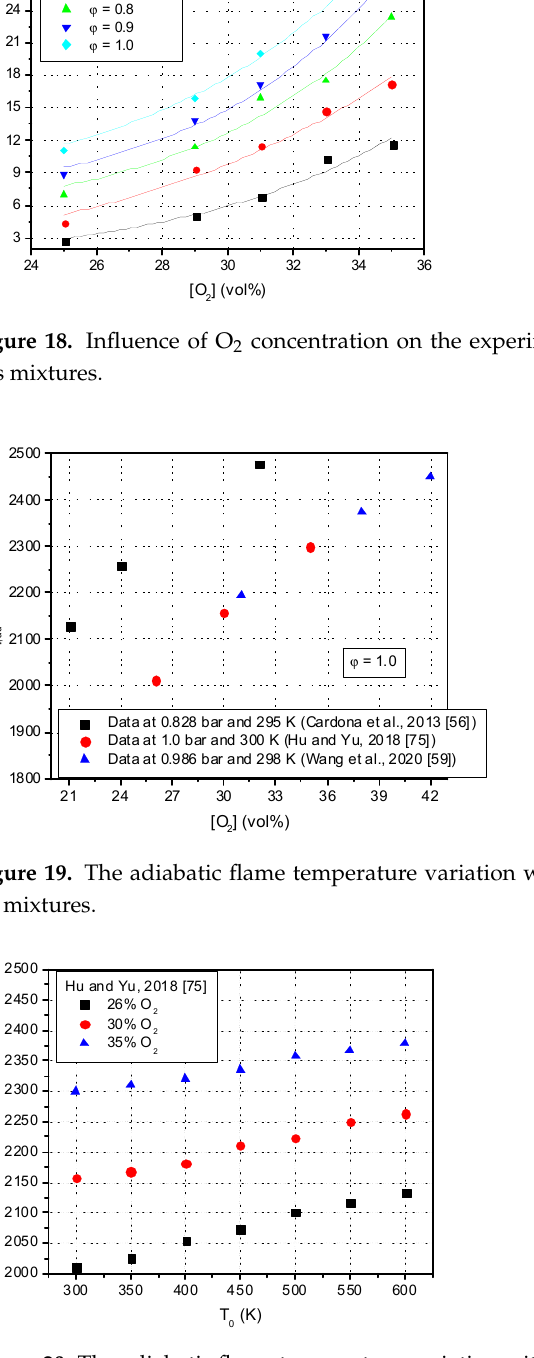
Figure 21. Influence of initial temperature on experimental laminar burning velocity of oxygen- enriched biogas mixtures. It was found that there are three ways for the initial temperature affecting the laminar burning velocity [67]. The first factor is through the reaction rate and the adiabatic flame temperature. The increase in the adiabatic flame temperatures accelerates the reaction